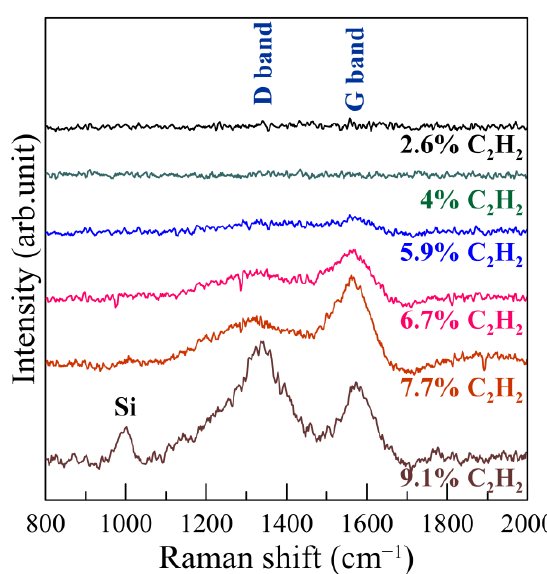
Figure 3. Raman spectra of Cr–C films deposited on the Si (100) substrate with a substrate bias of −150 V at 0.8 Pa deposition atmosphere with different C 2 H 2